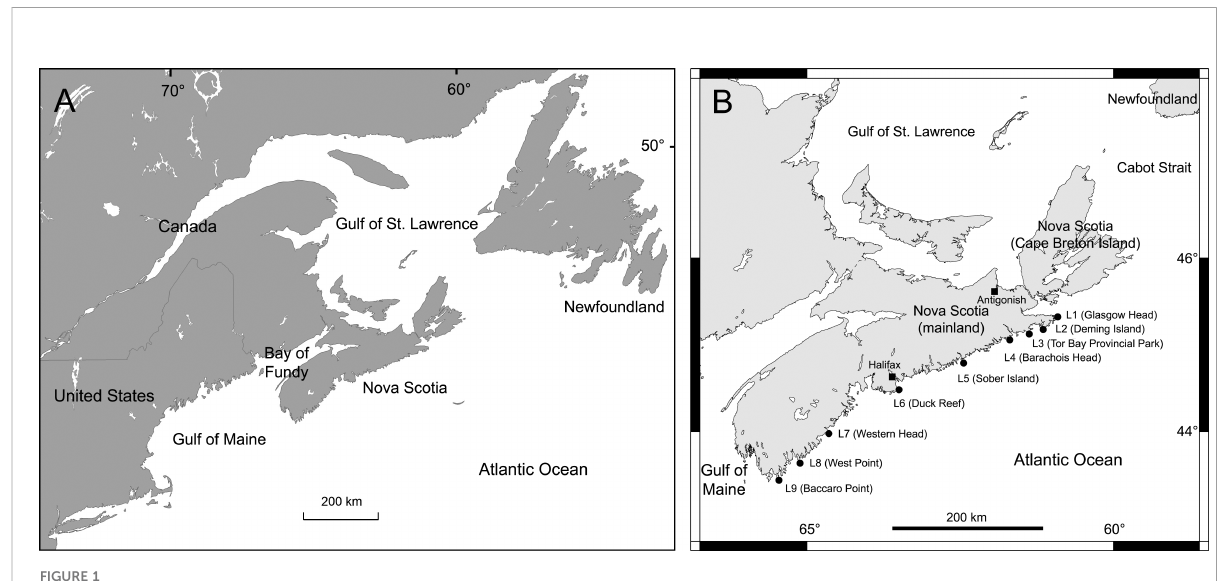
FIGURE 1 (A) Map showing the hydrographically distinct subregions of the cold-temperate NW Atlantic biogeographic region where rocky substrate is naturally abundant (Newfoundland, Gulf of St. Lawrence, open Atlantic coast of Nova Scotia, Bay of Fundy, and Gulf of Maine) and (B) map showing the position of the nine wave-exposed rocky intertidal locations surveyed for this